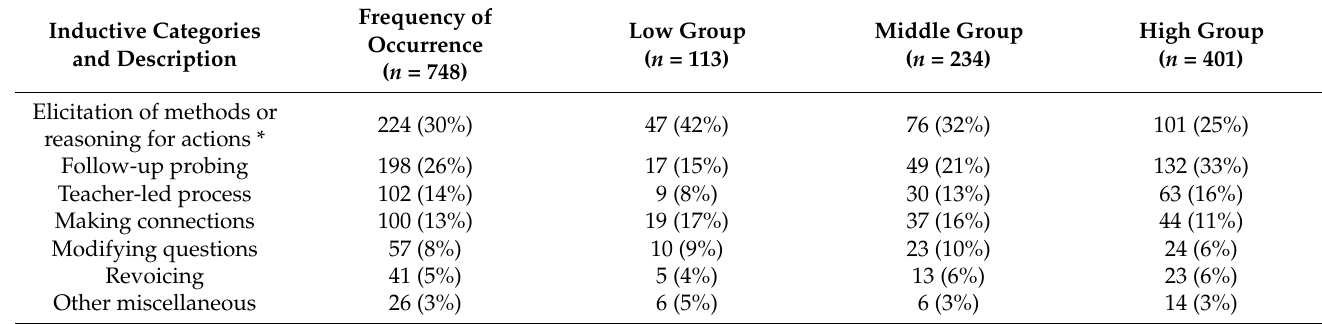
Table 5. Analysis of teacher talk during active